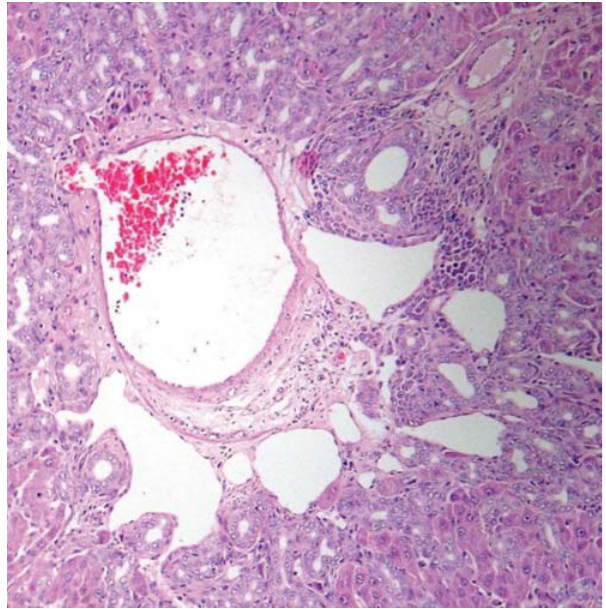
Figure 4 - Severe hepatic injury and fibrosis in the prolonged obstructive jaundiced group of